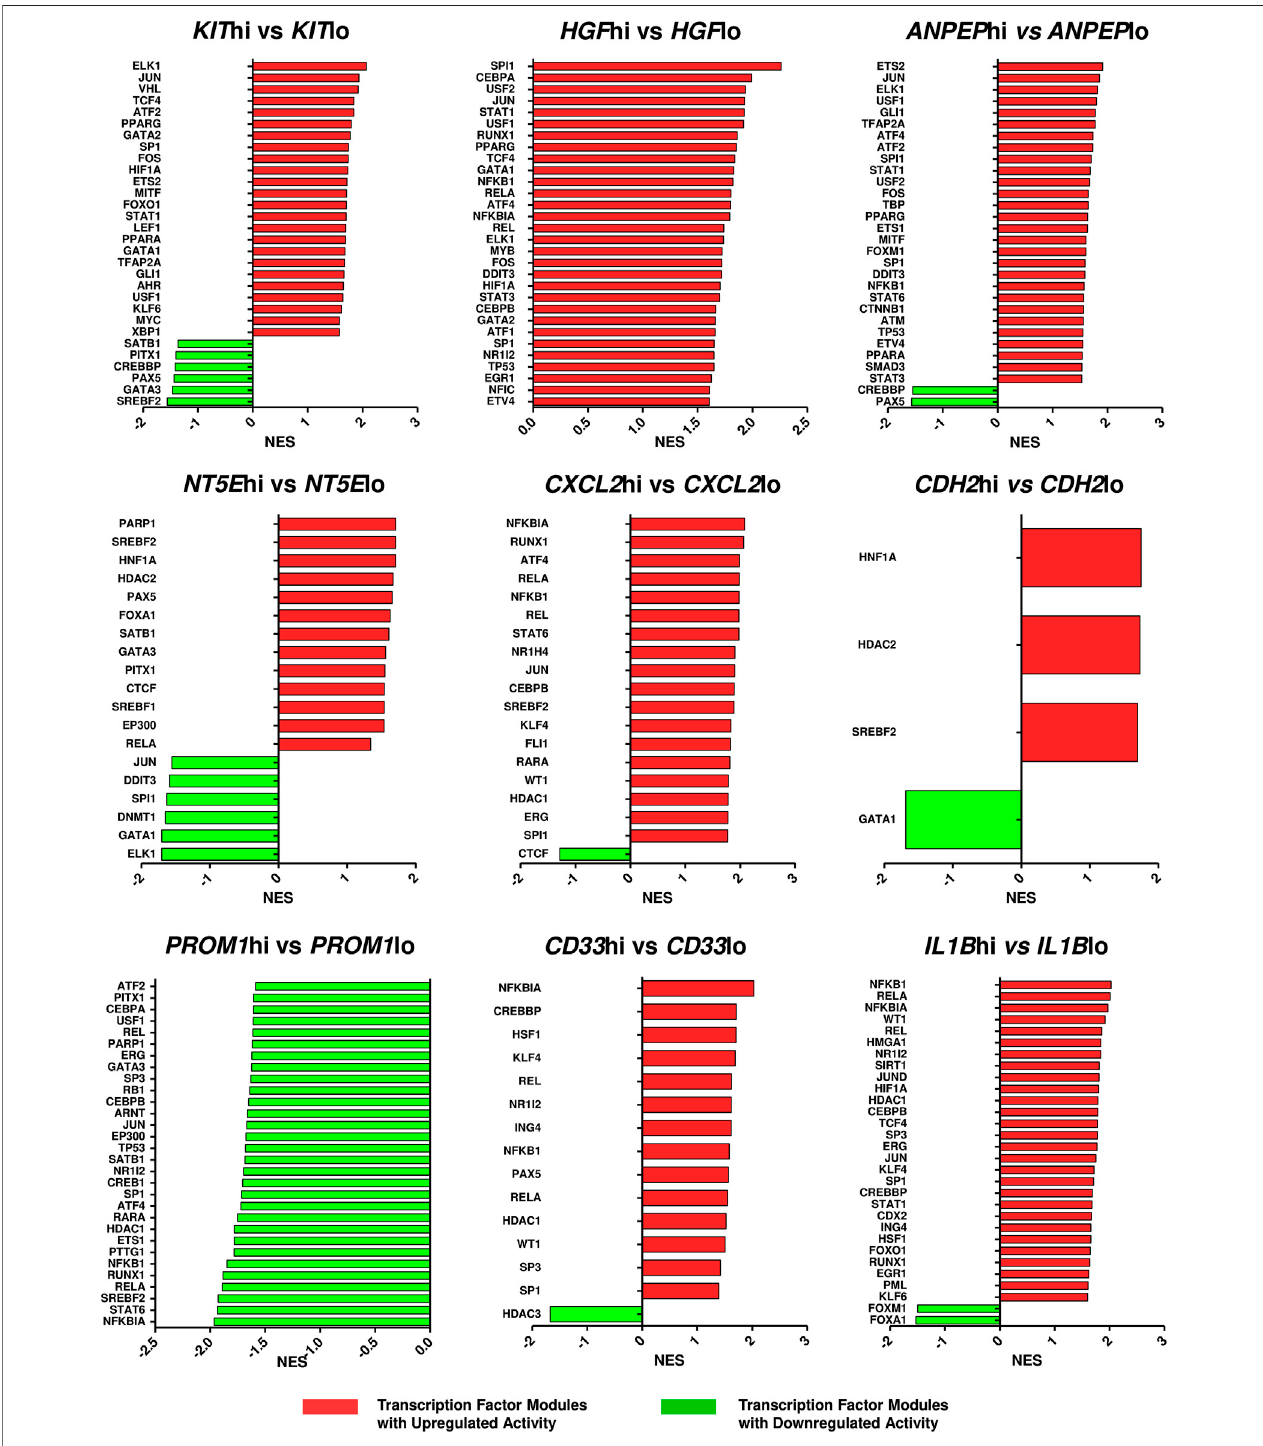
FIGURE 5 | Altered activities of transcription factors across ETP-ALL subpopulations expressing different levels of the hub genes. The ETP-ALL cohort from the GSE28703datasetwasdividedintosubpopulationsonthebasisofhighandlowlevelsofindividualhubgeneexpression(detailsin ‘ Enrichmentanalysis ’ under ‘ Materials & Methods ’ ), followed by GSEA against the ‘ TF.Target.TRRUST ’ database. Normalized enrichment score (NES) of top 30 transcription factor modules, at most, were represented on the column plots.